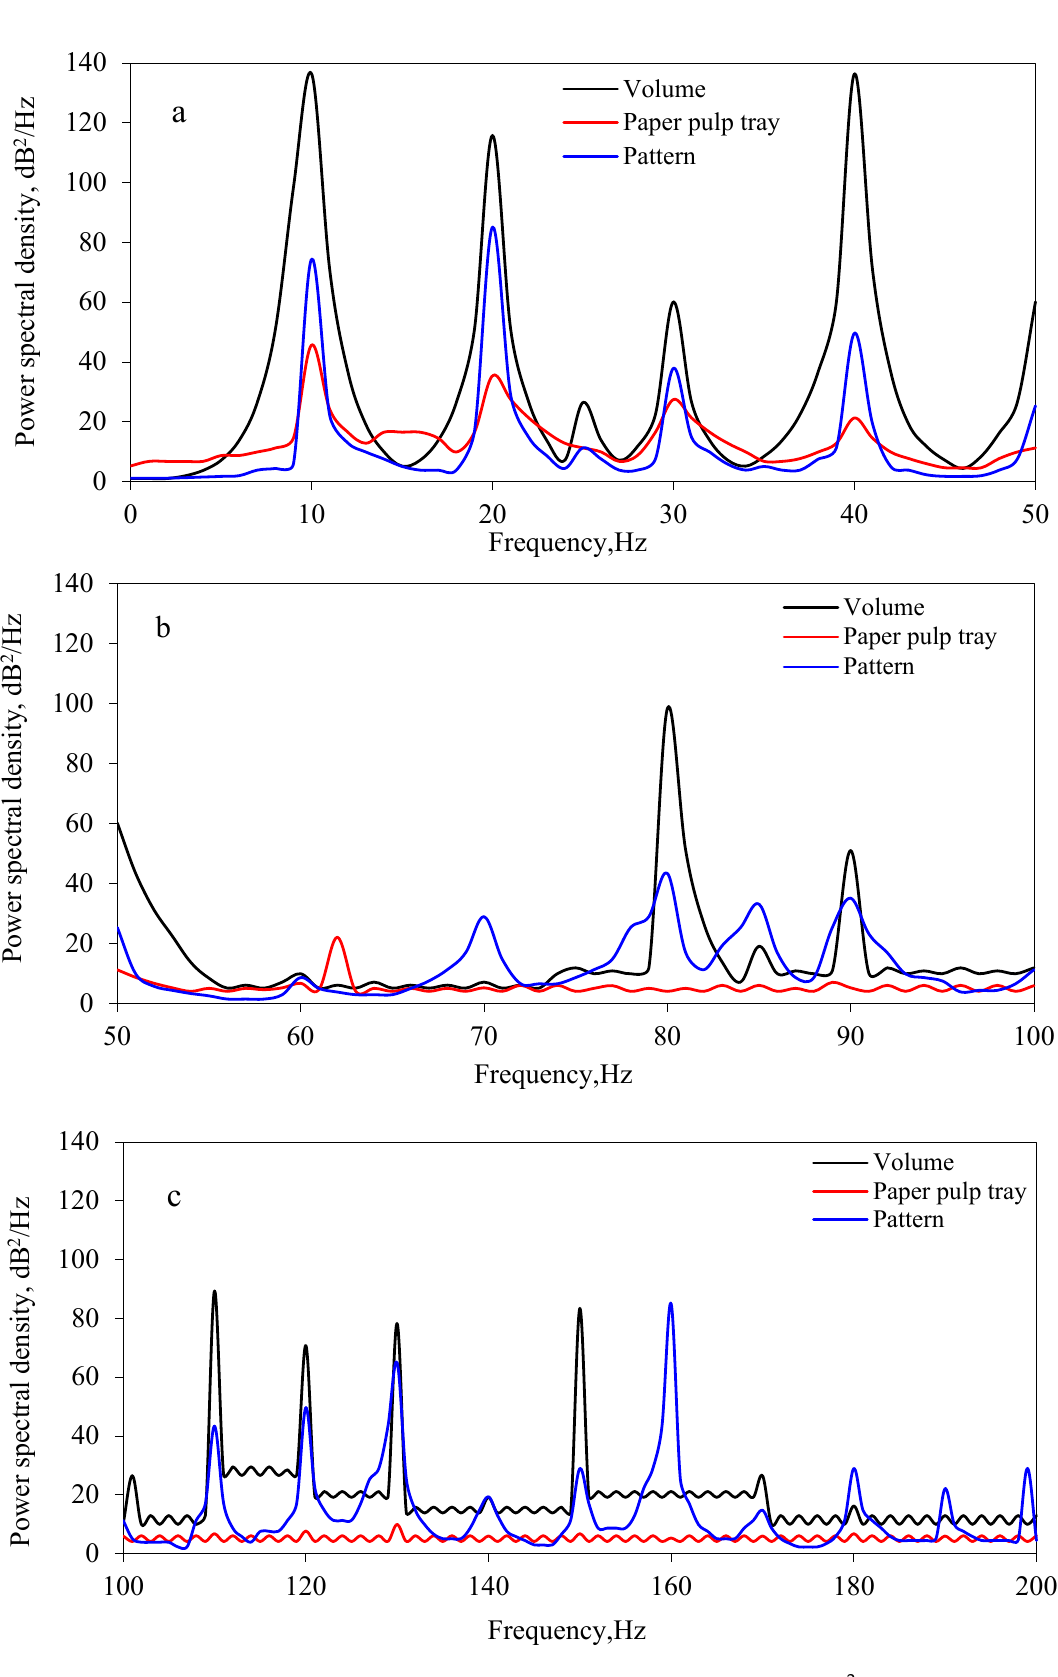
Figure 13. Relationship between the power spectral density, dB 2 /Hz, and frequency (Hz) of can- taloupe with different packing methods and a duration of 5 min: ( a ) 0–50 Hz, ( b ) 50–100 Hz, ( c ) 100–200 Hz.